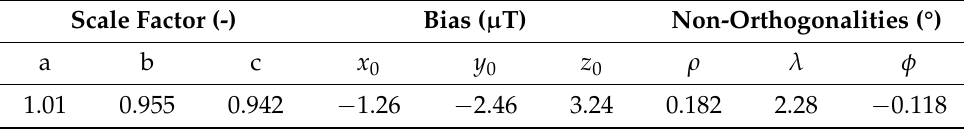
Table 1. Calibration parameters of RM3100 magnetometer from indoor flight tests. Scale Factor